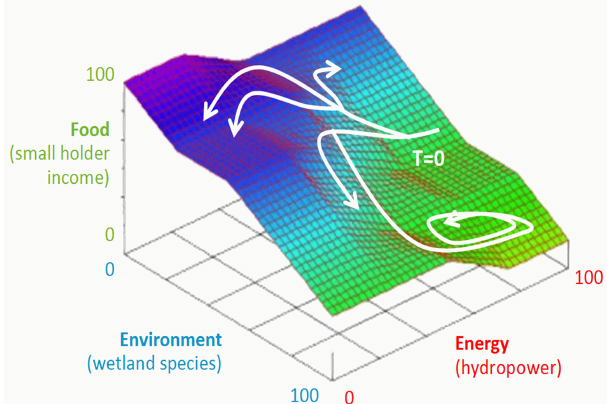
Figure 8. Trajectories illustrating the future possibility space that may be predicted by a socio-hydrological model addressed to man- agement of the water–food–energy–environment nexus (taken from Srinivasan et al.,